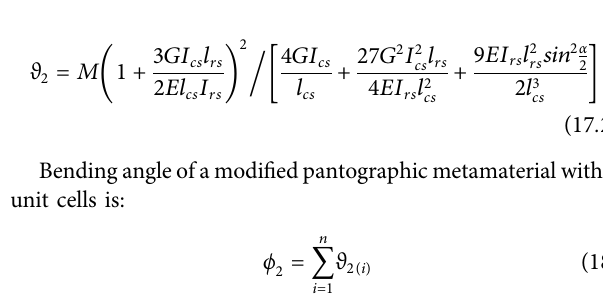
Frontiers in Mechanical Engineering |